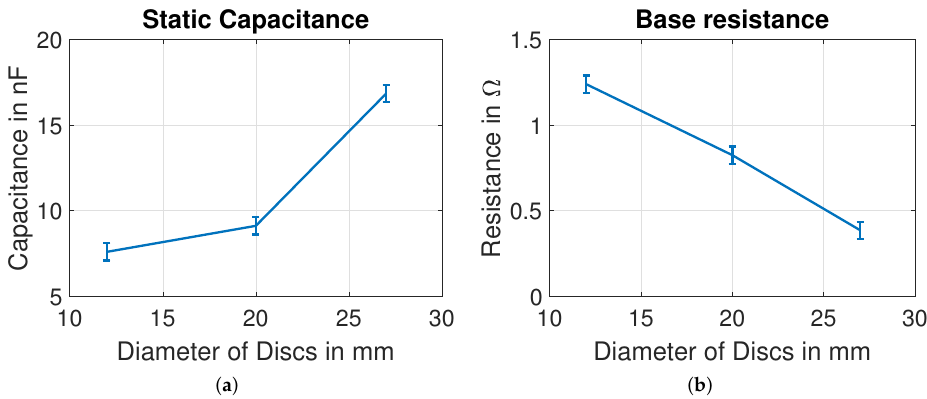
Figure 16. Influence of diameter on ( a ) static capacitance ( b ) base resistance of PZT discs.